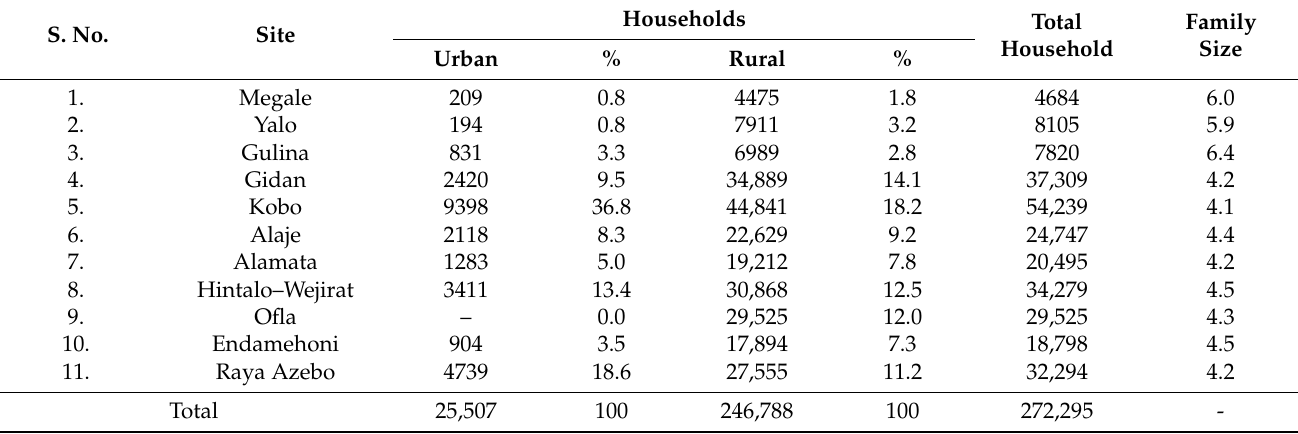
Figure 1. Location of the study area showing the different land features and elevation. Table 1. Total households and family size of the study area by